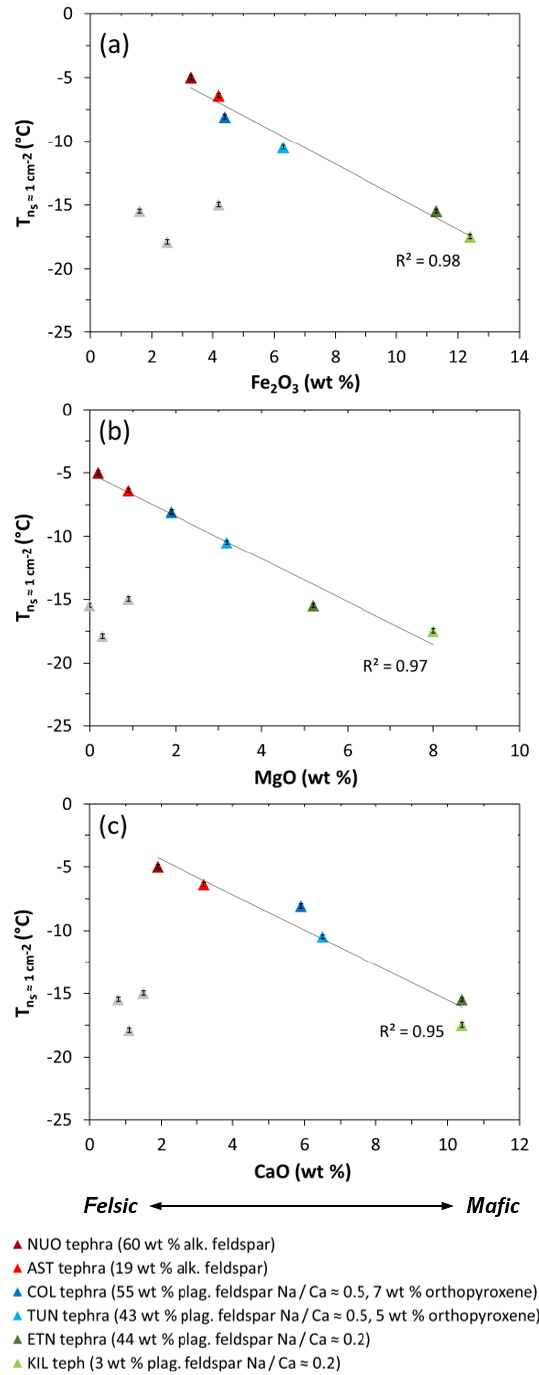
Figure 6. The INA ( T n − 2 ) of NUO teph , AST teph , COL teph , s ≈ 1cm TUN teph , ETN teph , and KIL teph versus their (a) Fe 2 O 3 , (b) MgO, and (c) CaO contents. The grey triangles correspond to tephra samples with comparatively low crystallinities (LIP teph , CID teph , LAC teph ), which are excluded from the trend line. Ice nucleation experiments were conducted with 1wt% suspensions of tephra in water. The uncertainty in T n − 2 is shown as error bars (note s ≈ 1cm that these are as small as the data symbols). Sample codes are listed in Table